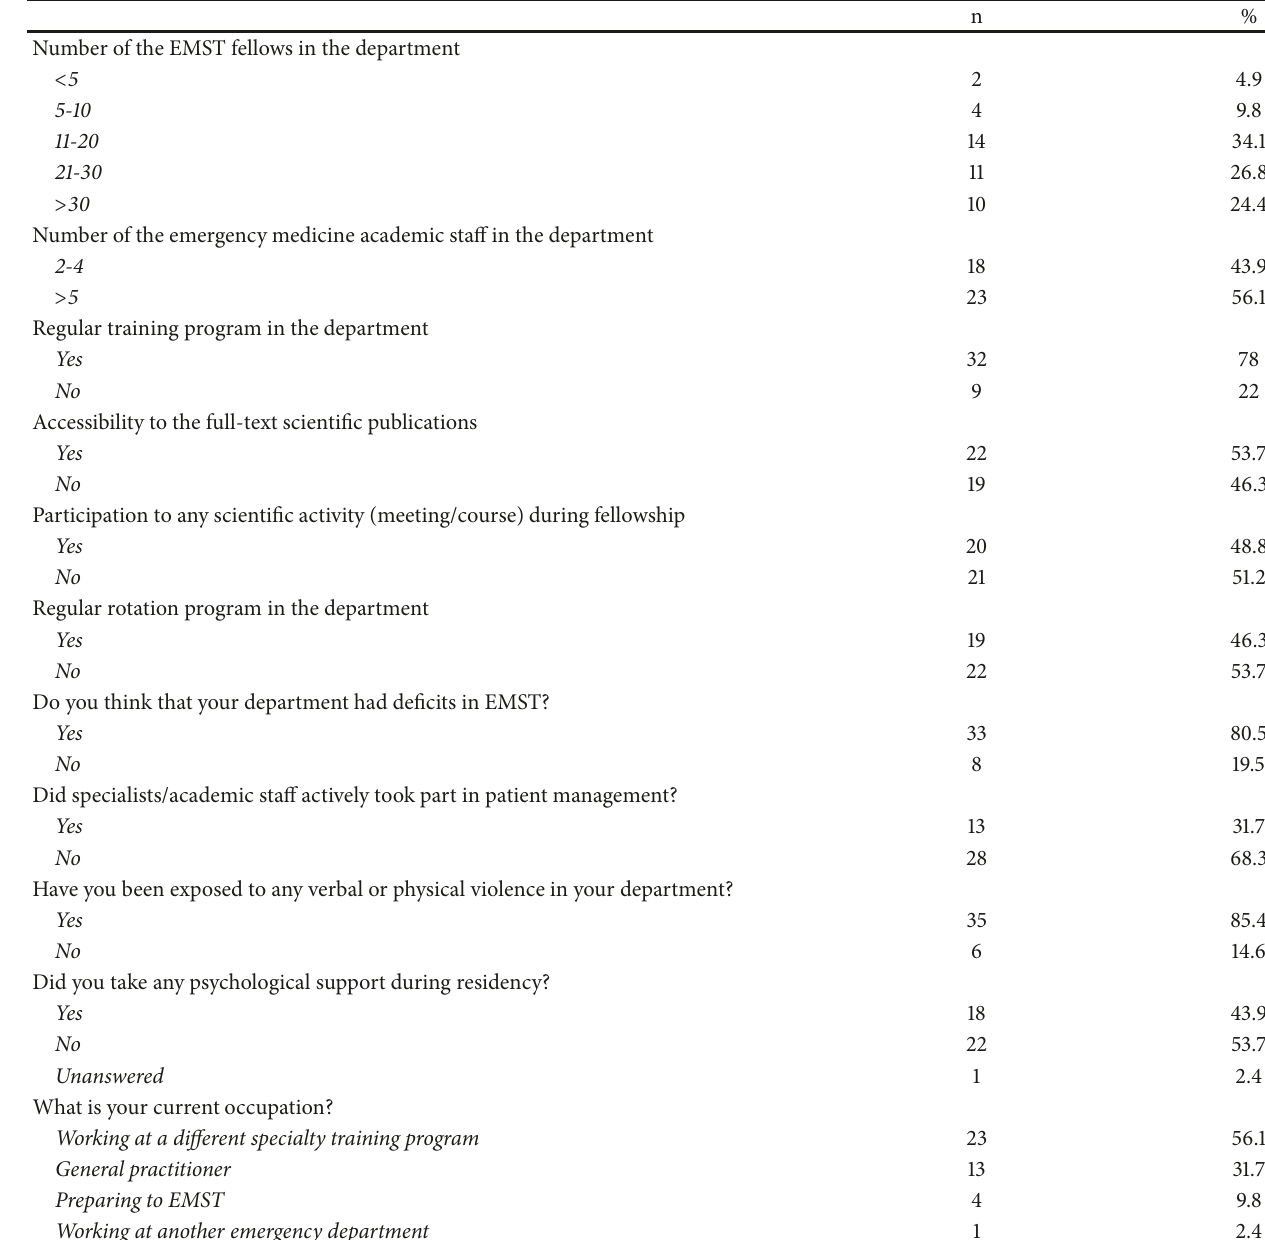
Table 2: Characteristics of the department